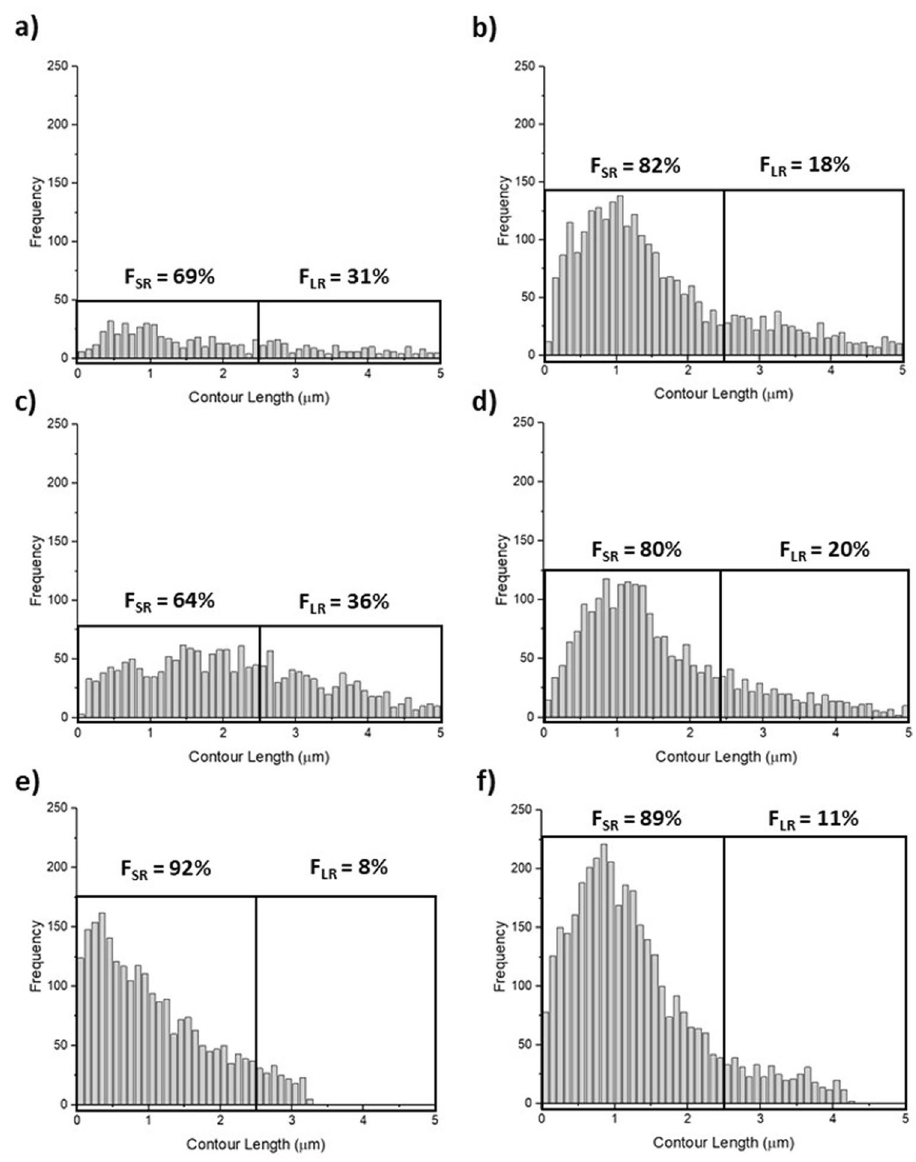
Figure 4. Showing histograms and percentages of long range (> 2.5 µm) (FSLR) and short range (< 2.5 µm) (FSSR) fitted segments (total number of unbinding events) for ( a ) HB-PNIPAM-Van- S. aureus at stage 1, ( b